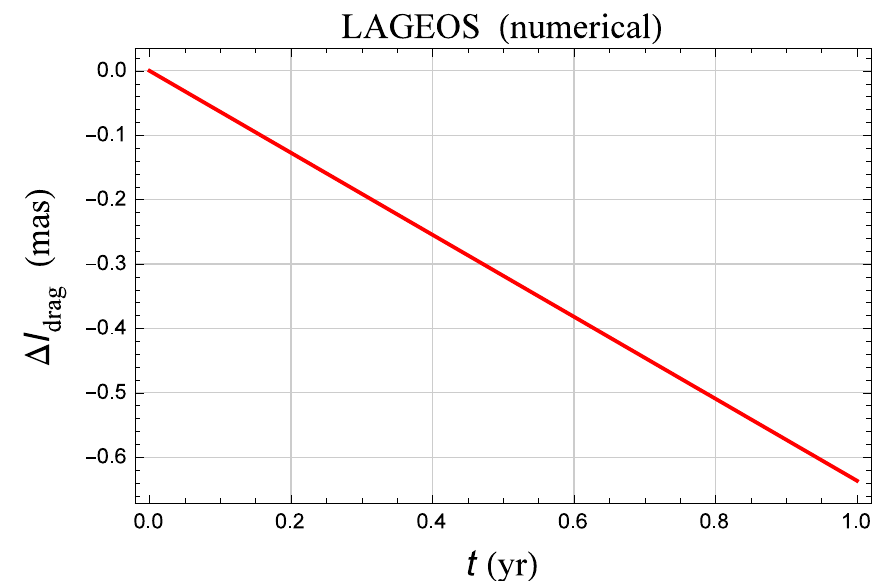
Figure A6. Numerically produced time series of the inclination shift ∆ I drag , in mas, of LAGEOS over a time span T = 1 yr as a result of the difference of two numerical integrations of its equations of motion in Cartesian coordinates with and without the drag acceleration, calculated with the values of the neutral and charged drag parameters of Equations (40) and (46), sharing the same initial conditions provided in a personal communication to the author by a colleague. A secular rate of ˙ I L = − 0.7 mas yr − 1 is neatly apparent. drag